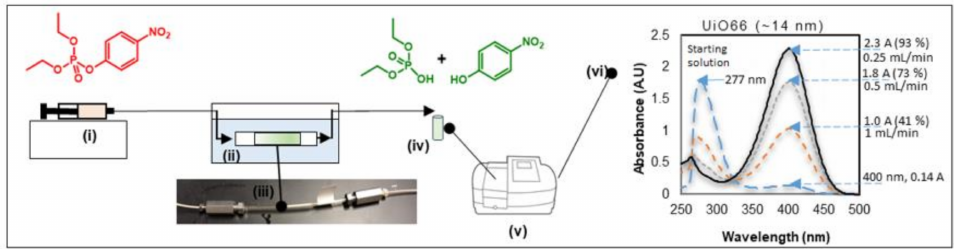
Figure 1. Experimental testing setup and analysis. ( i ) Syringe pump, ( ii ) water bath, ( iii ) loaded MOF catalyst in a capillary flow reactor, ( iv ) collected sample in a vial, ( v ) UV–Vis spectroscopy, ( vi ) example of one of the results, including reference starting